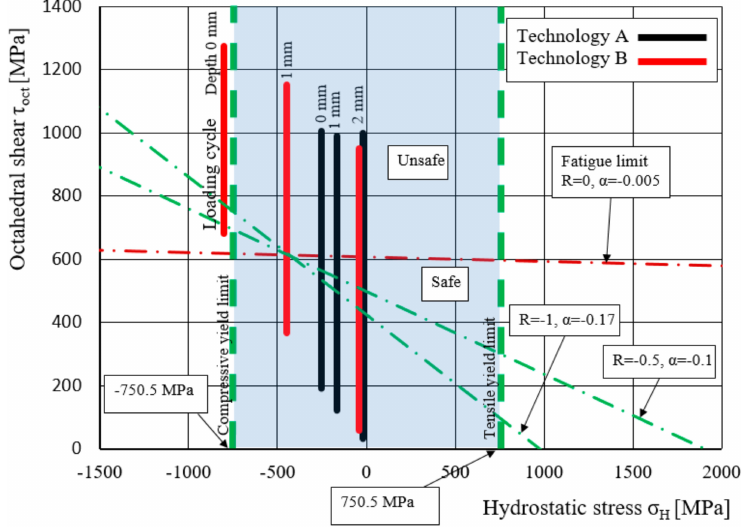
Figure 11. Fatigue criterion in the octahedral shear–hydrostatic stress